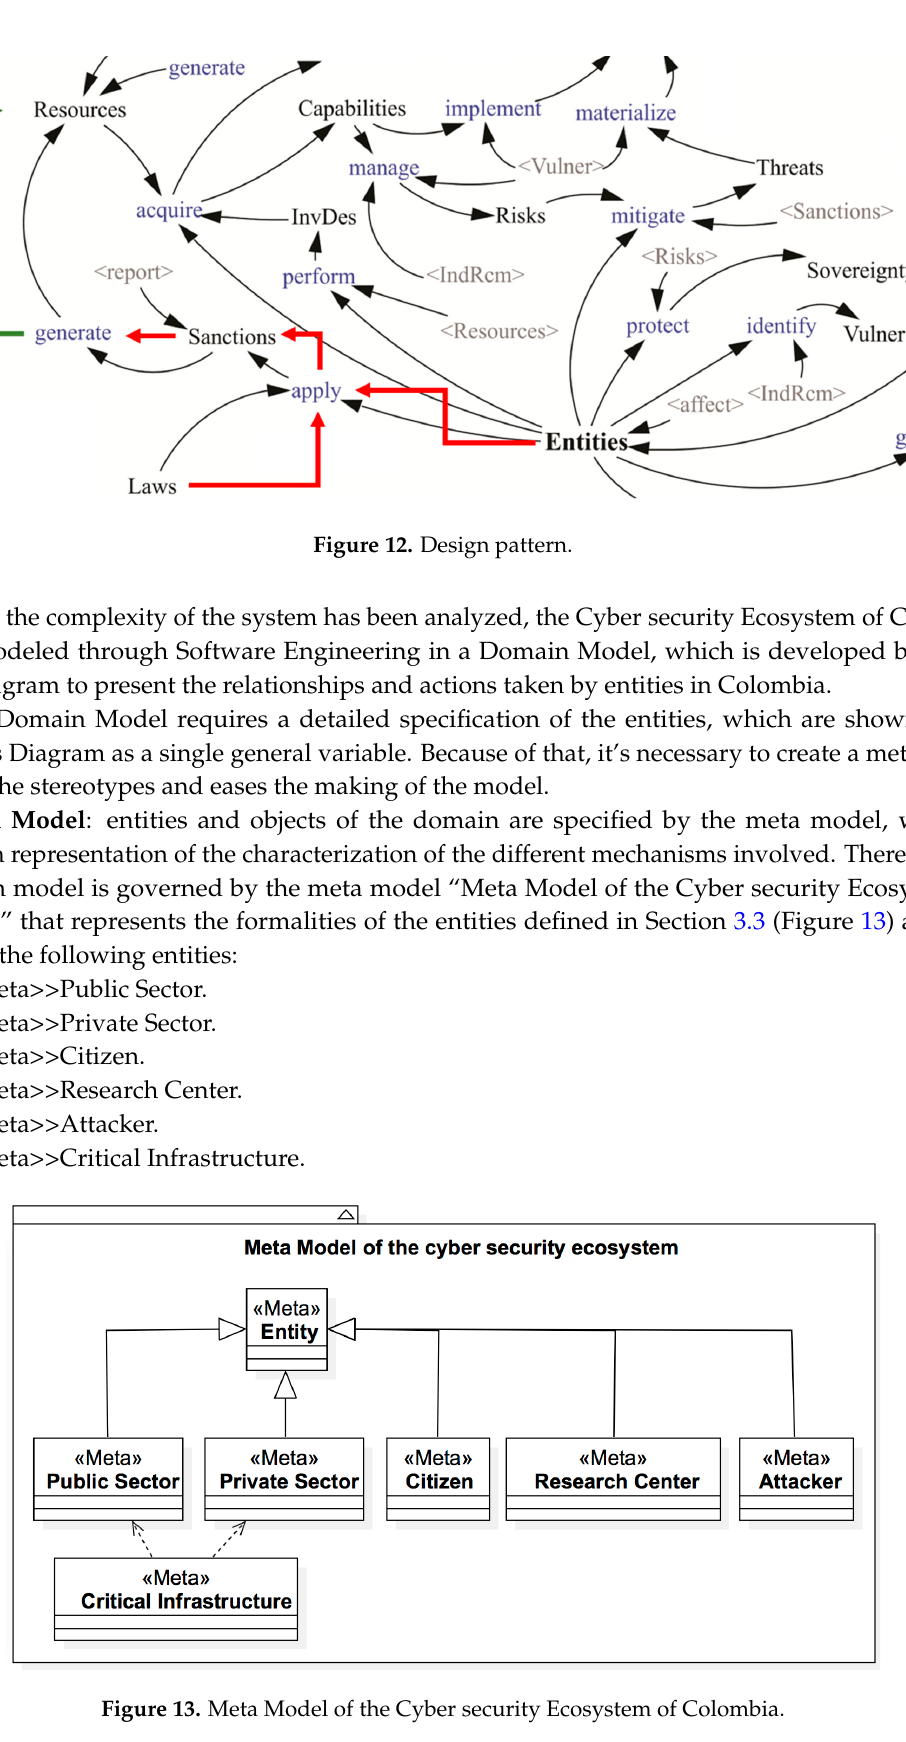
Figure 13. Meta Model of the Cyber security Ecosystem of Colombia.